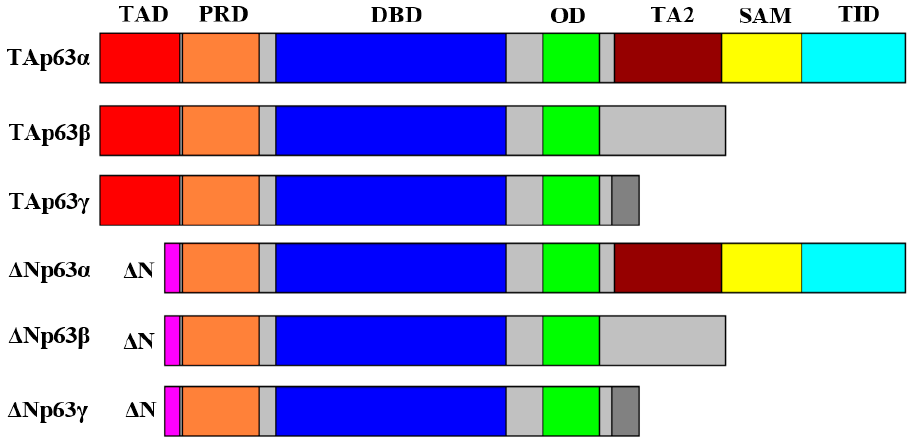
Figure 1. Six isoforms of p63 including all domains of each transcript including the transactivation domain (TAD), the proline-rich domain (PRD), the DNA-binding domain (DBD), the oligomerization domain (OD), the second transactivation domain (TA2), the sterile α motif domain (SAM), and the transactivation-inhibition domain (TID).